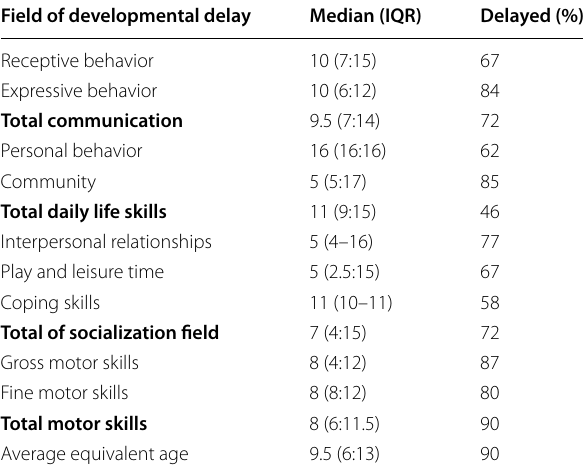
VABS Vineland Adaptive Behavior Scale, IQR interquartile